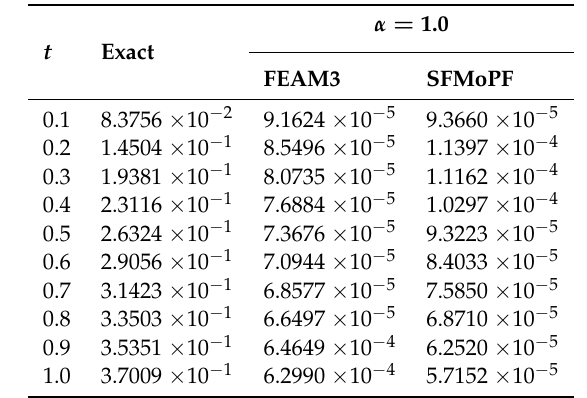
Table 10. Absolute error when α = 1.0 at each point, t using FEAM3 with N = 10 and SFMoPF in solving Example 4.